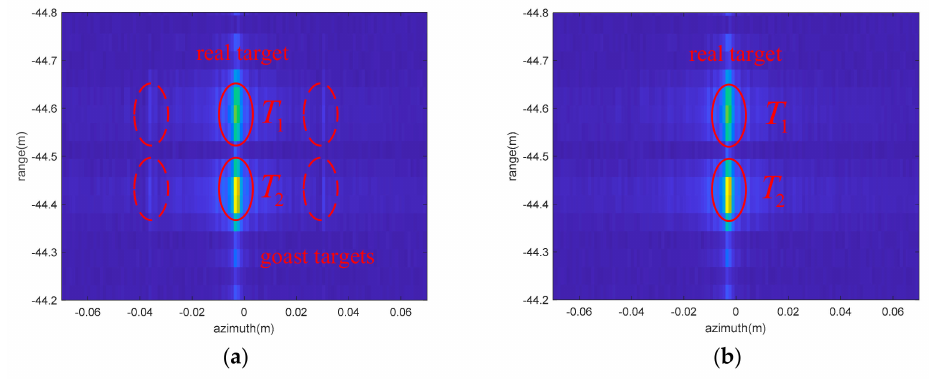
Figure 30. Imaging results ( a ) without compensation and ( b ) with compensation.